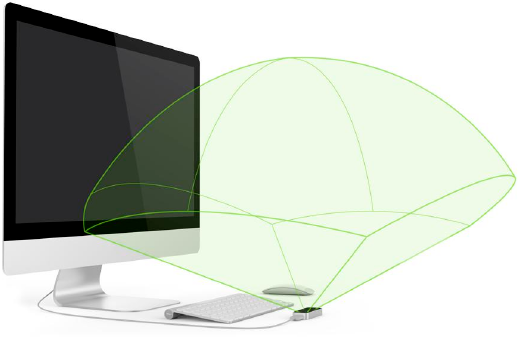
Figure 8. Leap Motion Sensor space.